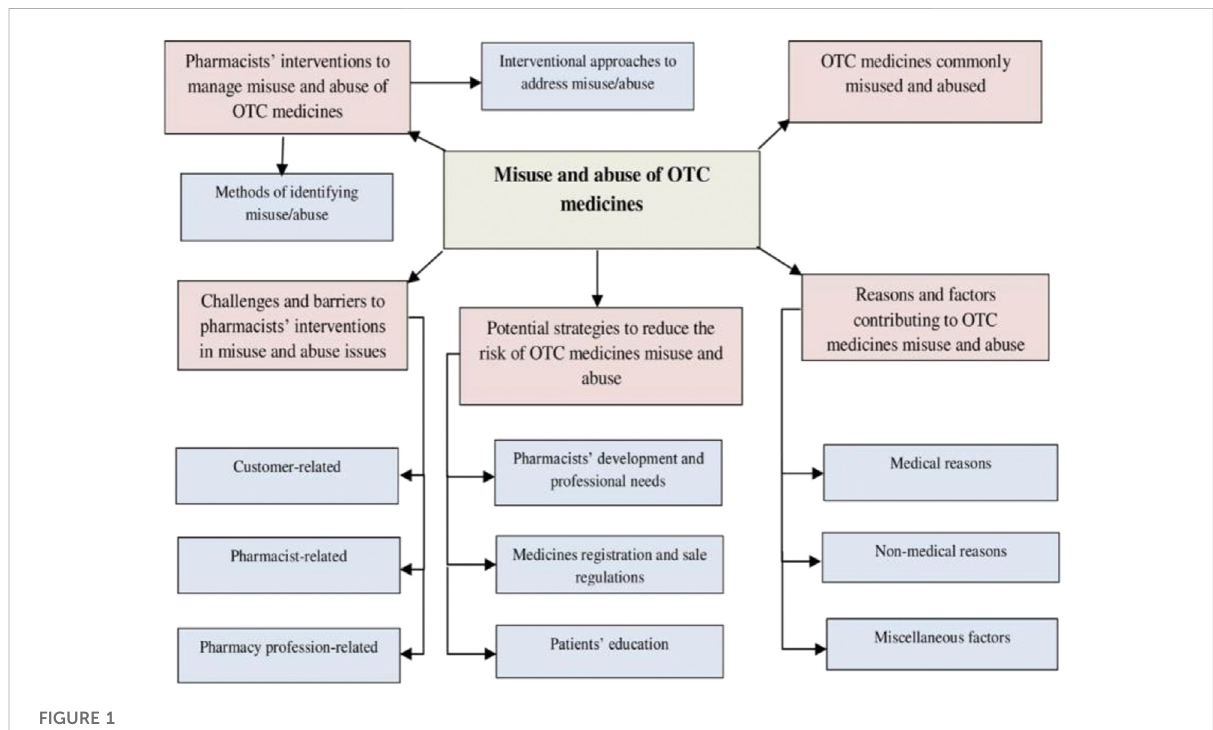
FIGURE 1 Emerged themes and